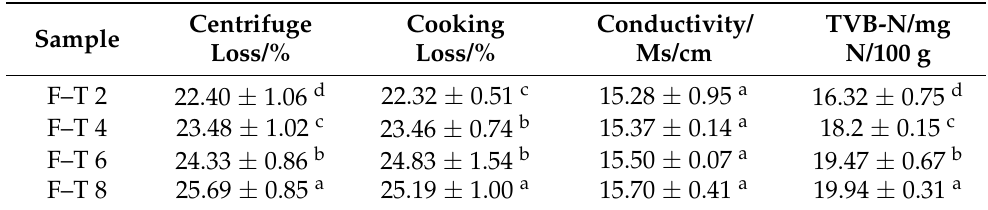
Table 1. The rate of centrifugal loss and cooking loss, conductivity, and TVB-N of the samples in varying freeze–thaw (F–T)